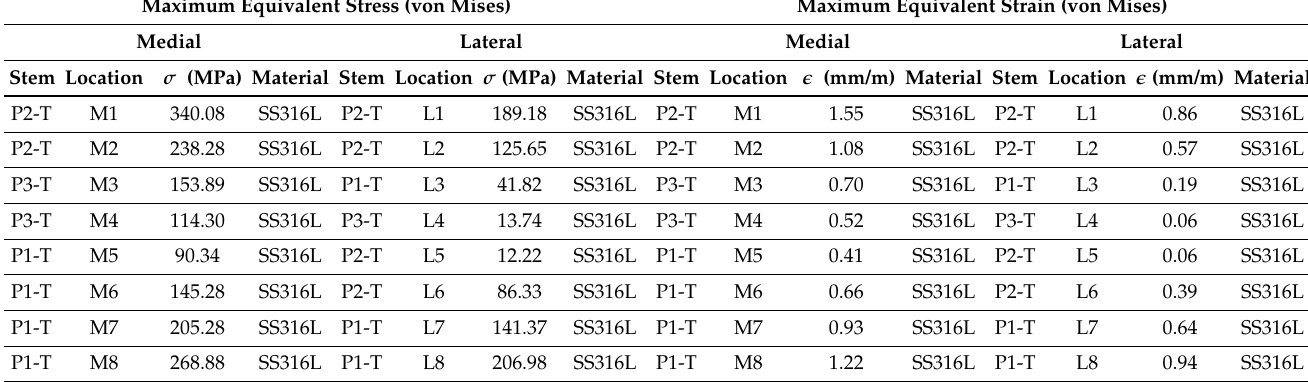
Table 5. Summary of the best results (lower values in stress and strain) of the generated reference points on the lateral and medial side of all stems from Appendix B. P1, P2, and P3 represent the profile numbers, and the letter represents the type of cross-section (T = trapezoidal, C = circular). The letters “M” and “L” stand for the medial and the lateral parts of the stem. The same boundary conditions and the mesh used in Sections 2.1.3 and 2.1.4 were used for the FEM